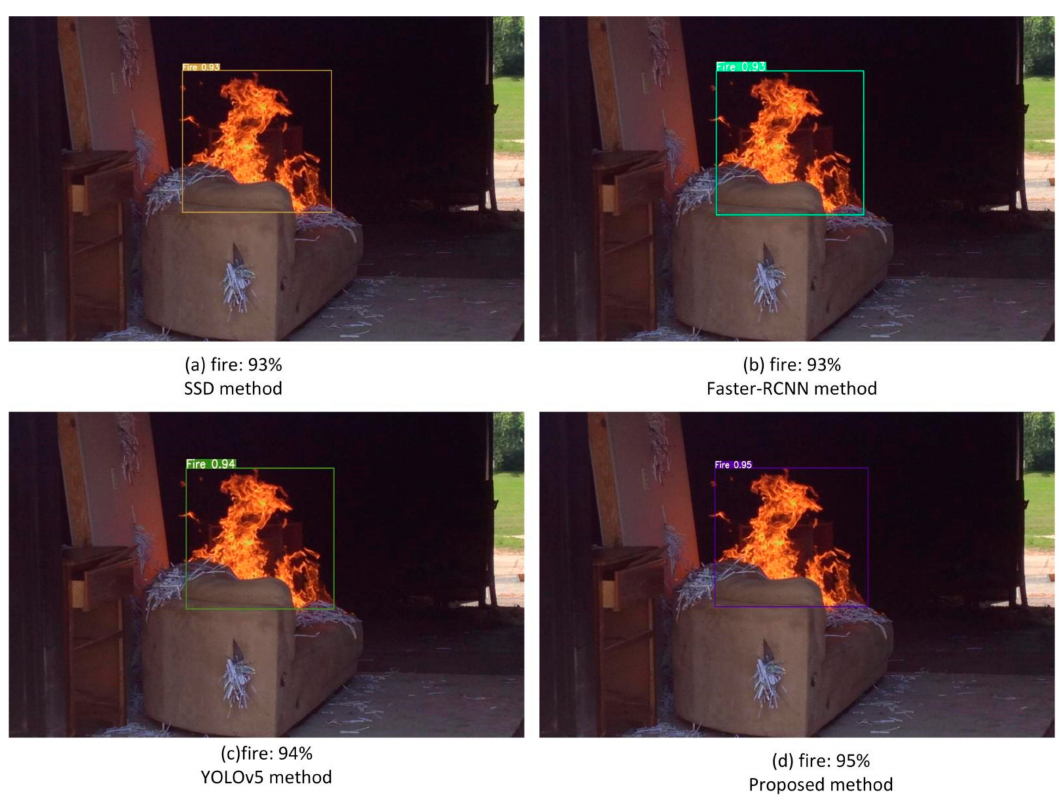
Figure 11. Fire detection at a short distance.